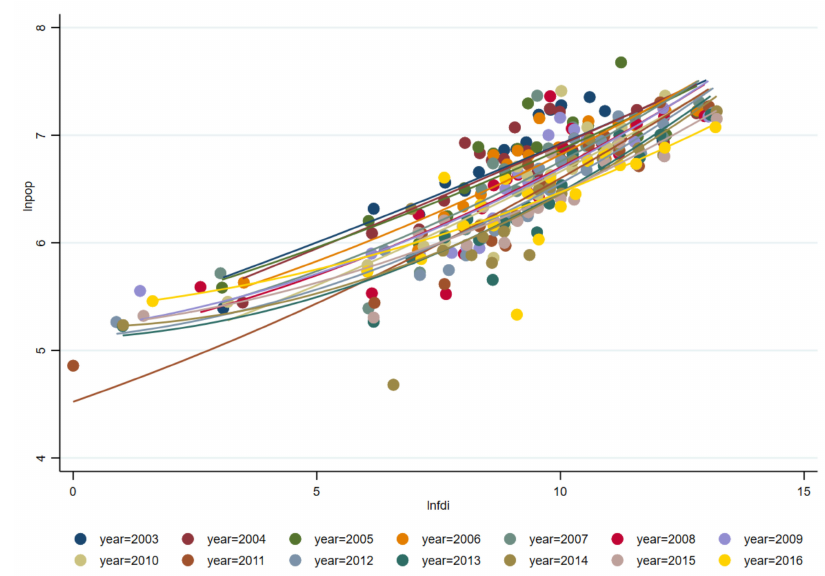
Figure 4. Fitting curve of population density and FDI from 2003 to 2016.